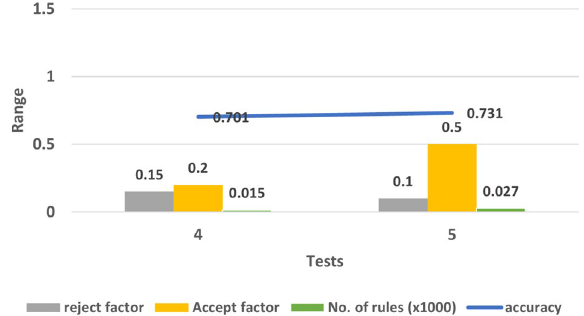
Figure 5. The impact of accept factor and reject factor on accuracy in test 4 and 5.